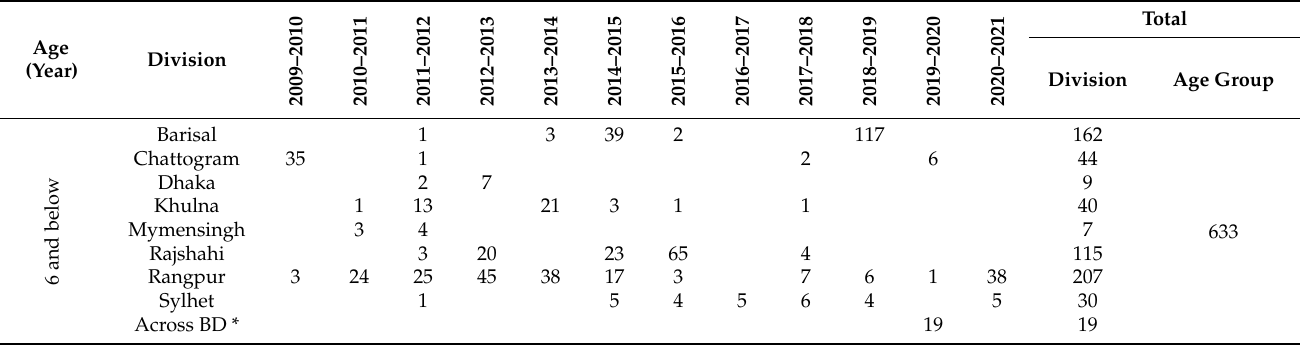
Table A2. Age distribution of cold-related deaths in the divisions of Bangladesh during the winter months of